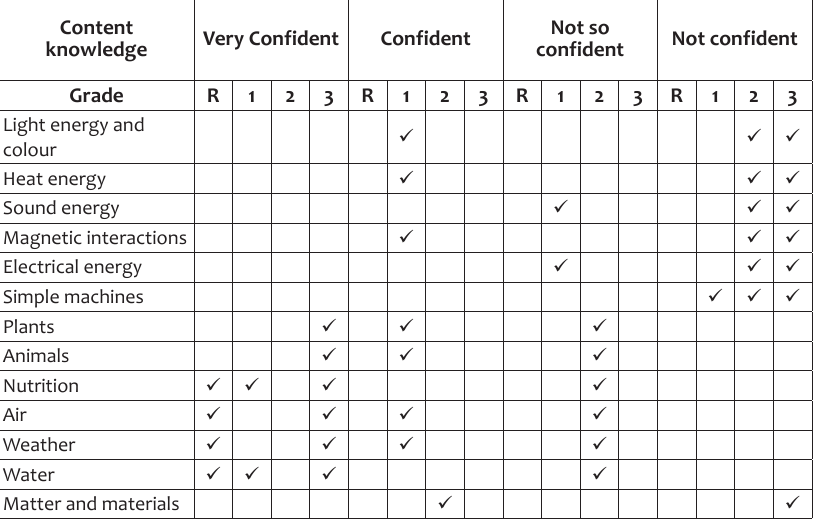
Table 1: The content areas that teachers were confident